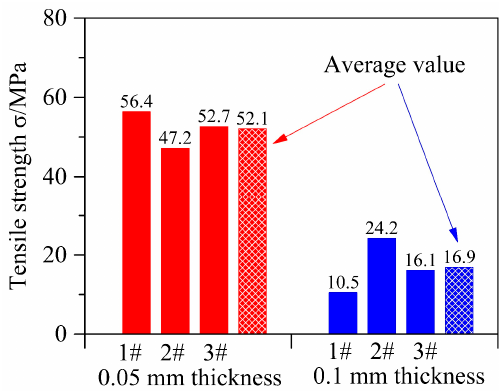
Figure 5. Tensile properties of the welded joints with different brass interlayer thicknesses.